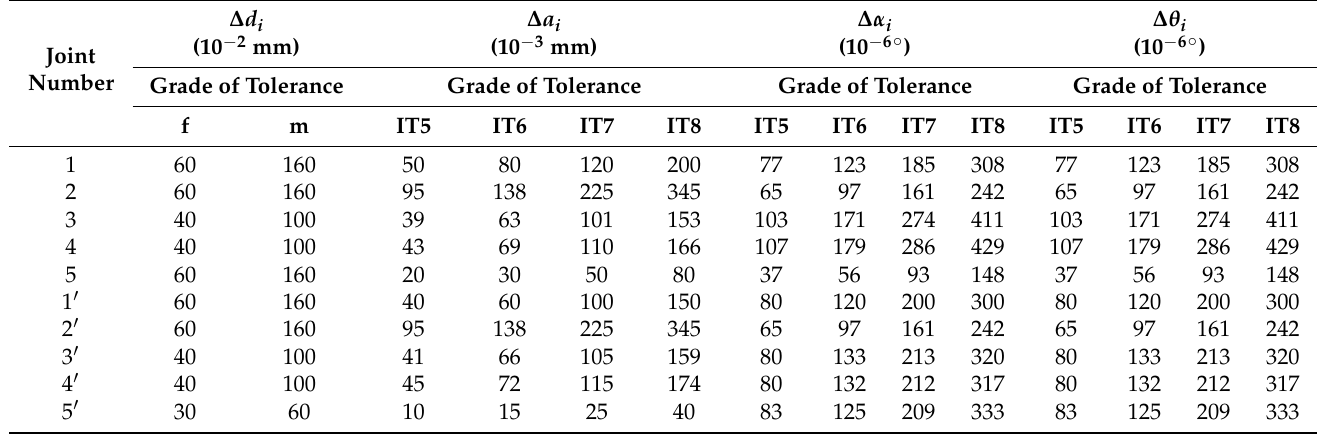
Table A2. The error limit of structural